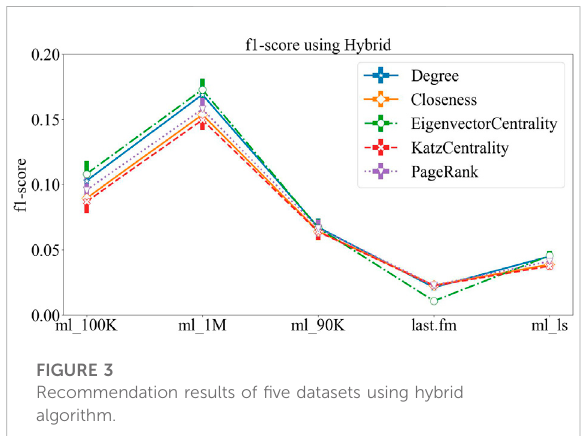
FIGURE 1 Results of different datasets using heat conduction.